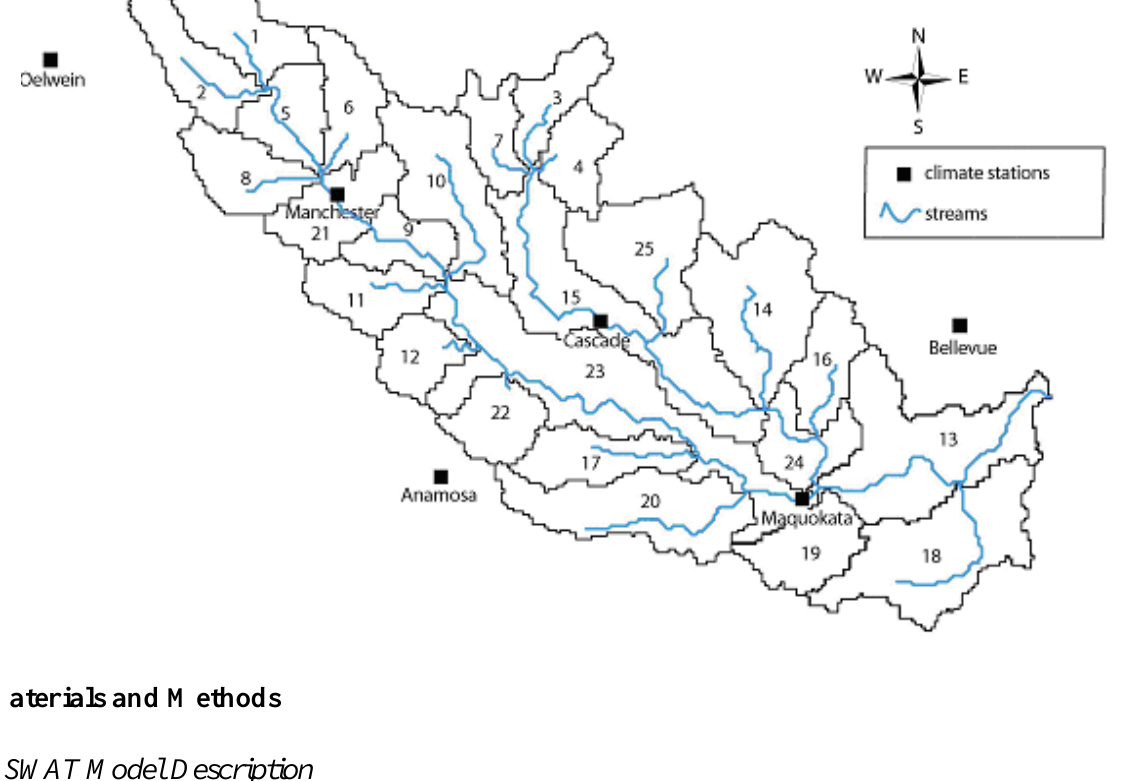
Figure 1. Location of the Maquoketa River watershed (Northeast Iowa), and weather